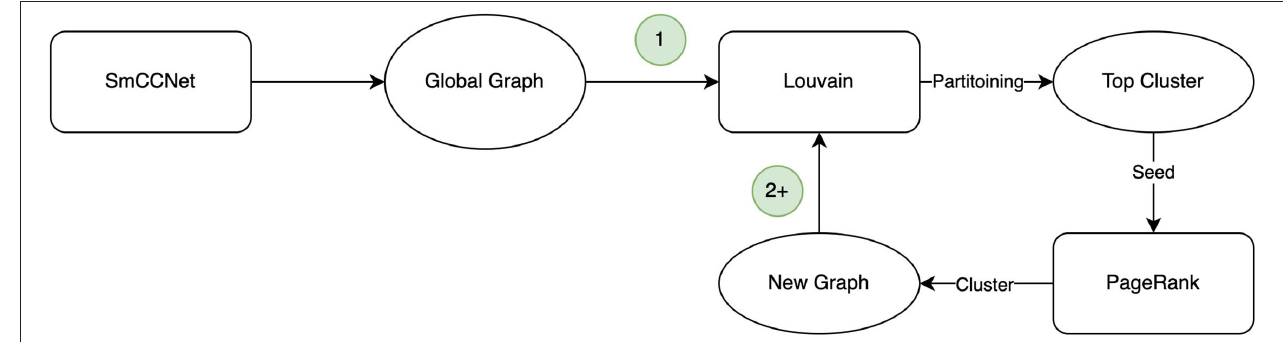
FIGURE 1 | Hybrid clustering procedure. The first iteration (1) uses the global graph provided by SmCCNet, with subsequent iterations (2 + ) using the cluster generated by PageRank in its